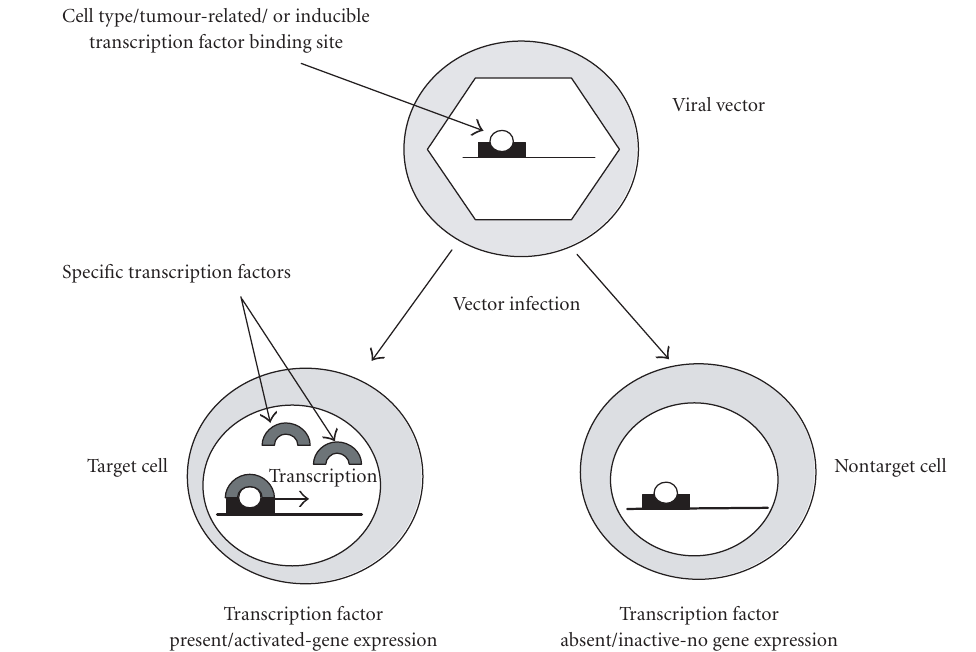
Figure 1. The use of specific tissue/tumour/inducible promoters to allow targeted transcription in tumour cells. Tissue-specific, tumour-specific, or inducible (eg, by radiation, drugs, etc) promoters can limit gene expression to target cells which express a specific transcription factor, or in which the transcription factors are activated